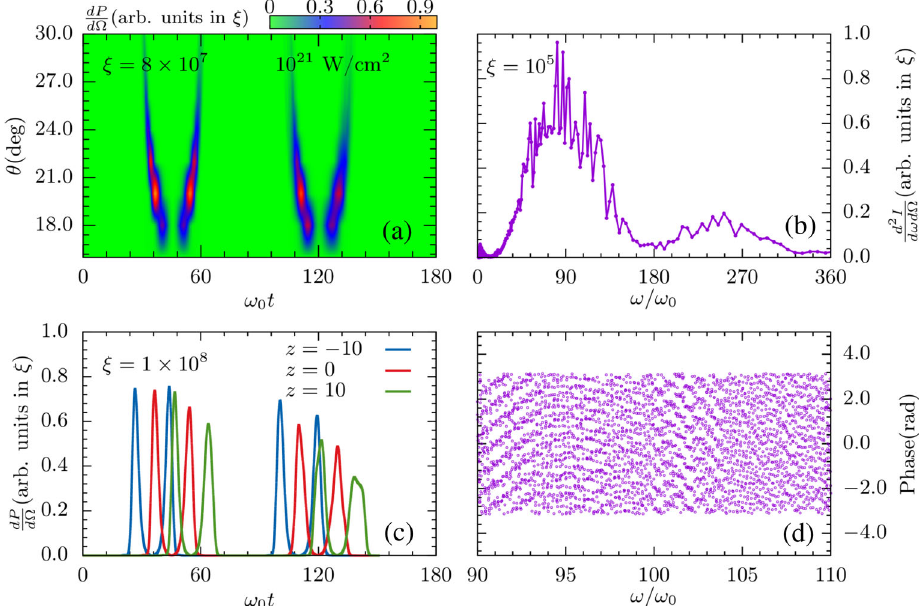
FIG. 7. The emitted attosecond pulses along different θ direction is corroborated in (a) with ϕ ¼ 180 °. However, for θ ¼ 20 ° (i.e., 10 21 W = cm 2 ) the spectrum of the emitted radiation (b), and corresponding phase (d) is presented. We have also presented the θ ¼ θ m for emitted attosecond pulses along θ ¼ 20 ° (c), for the cases when the cluster is centered around ð 0 ; 0 ; − 10 Þ , (0,0,0), and ð 0 ; 0 ; þ 10 Þ